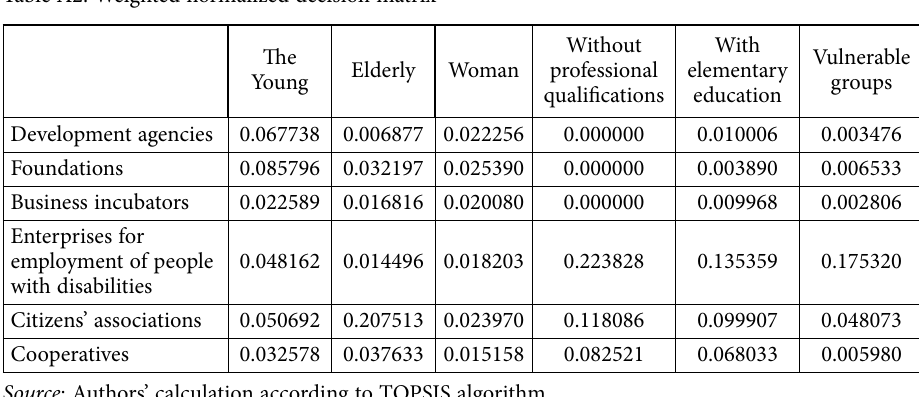
Table A2. Weighted normalized decision matrix